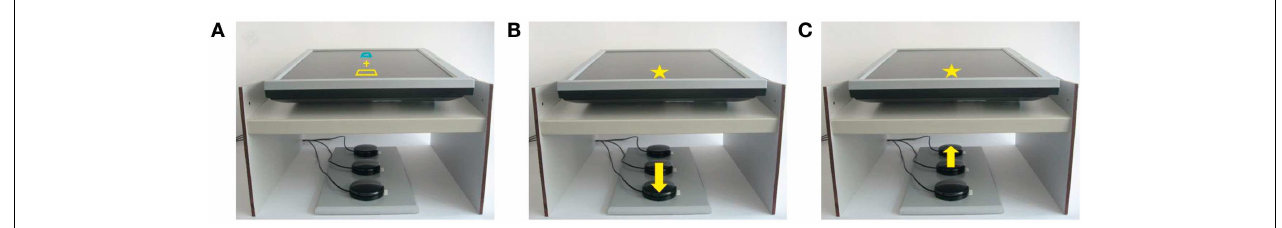
FIGURE 1 | Illustration of response fields and cue (A) and of arm movement and its effect by the example of a “yes” response in the yes-is-near condition with regular action-effect relation (B) and with inverted action-effect relation (C) .